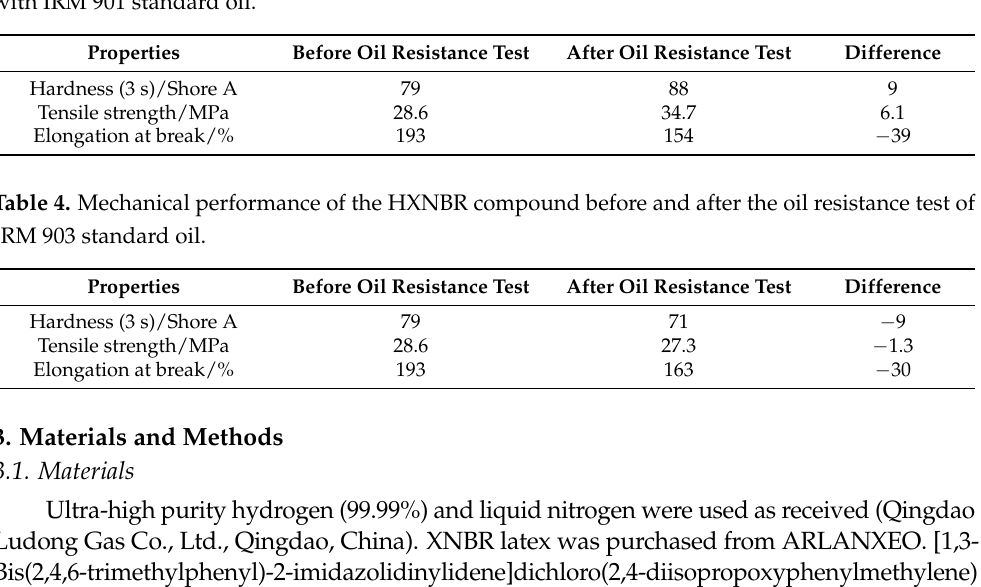
Table 3. Mechanical performance of the HXNBR compound before and after the oil resistance test with IRM 901 standard oil.